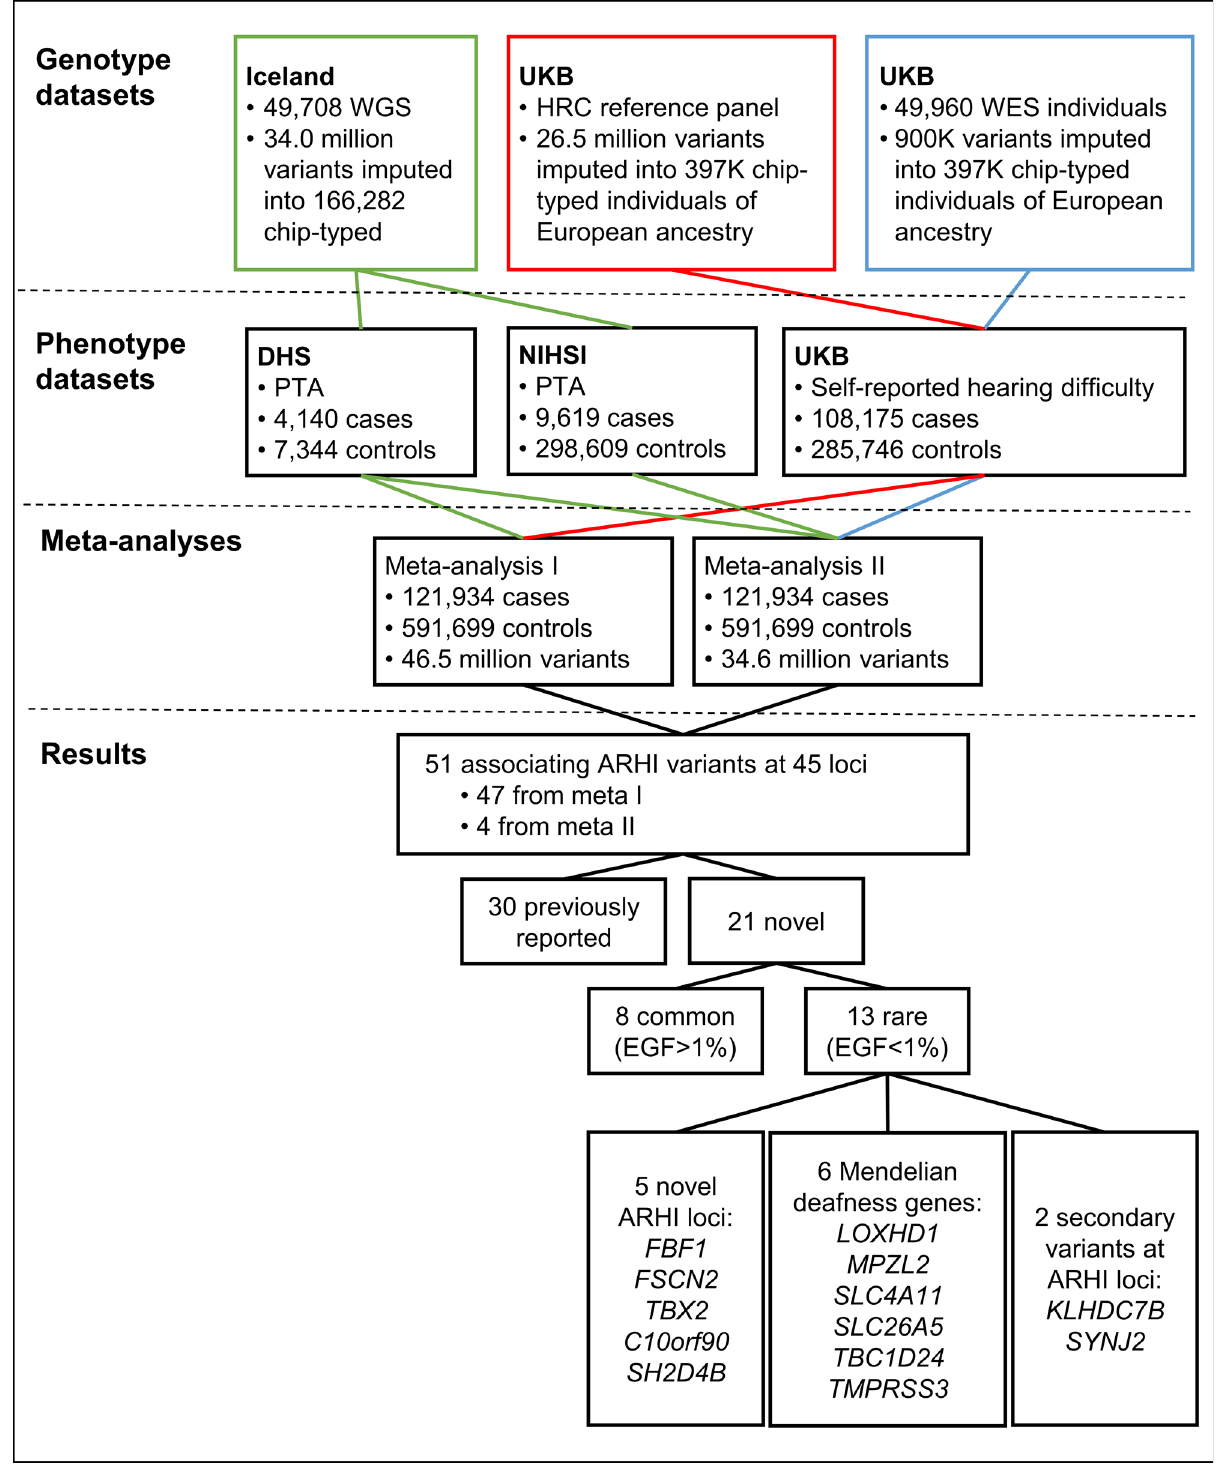
Fig. 1 Study design and summary of results. The UKB GWAS was performed with two genotype datasets marked in red and blue. The DHS and NIHSI GWAS was performed on one genotype dataset marked in green. WGS whole-genome sequenced, HRC Haplotype Reference Consortium, WES whole-exome sequenced, PTA pure tone average, DHS deCODE health study, NIHSI National Institute of Hearing and Speech in Iceland, EGF expected genotype